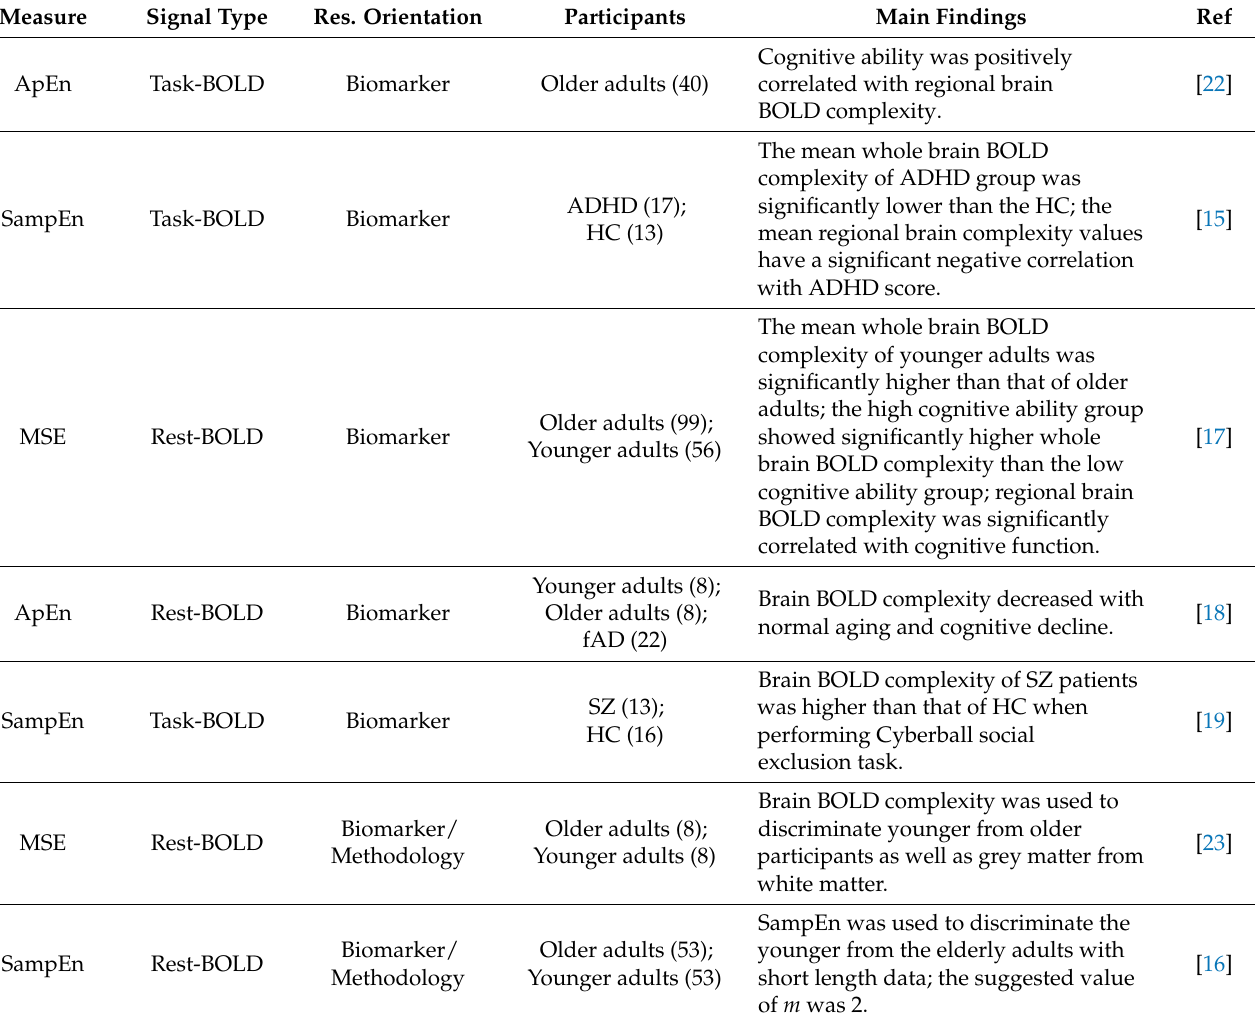
Figure 2. The relation between level of randomness and conventional entropy measure ( a ) and expected complexity ( b ). Reprinted with permission from ref. [49]. Copyright 2021 Elsevier. Table 1. A summary of literatures on brain blood-oxygen complexity analysis in since